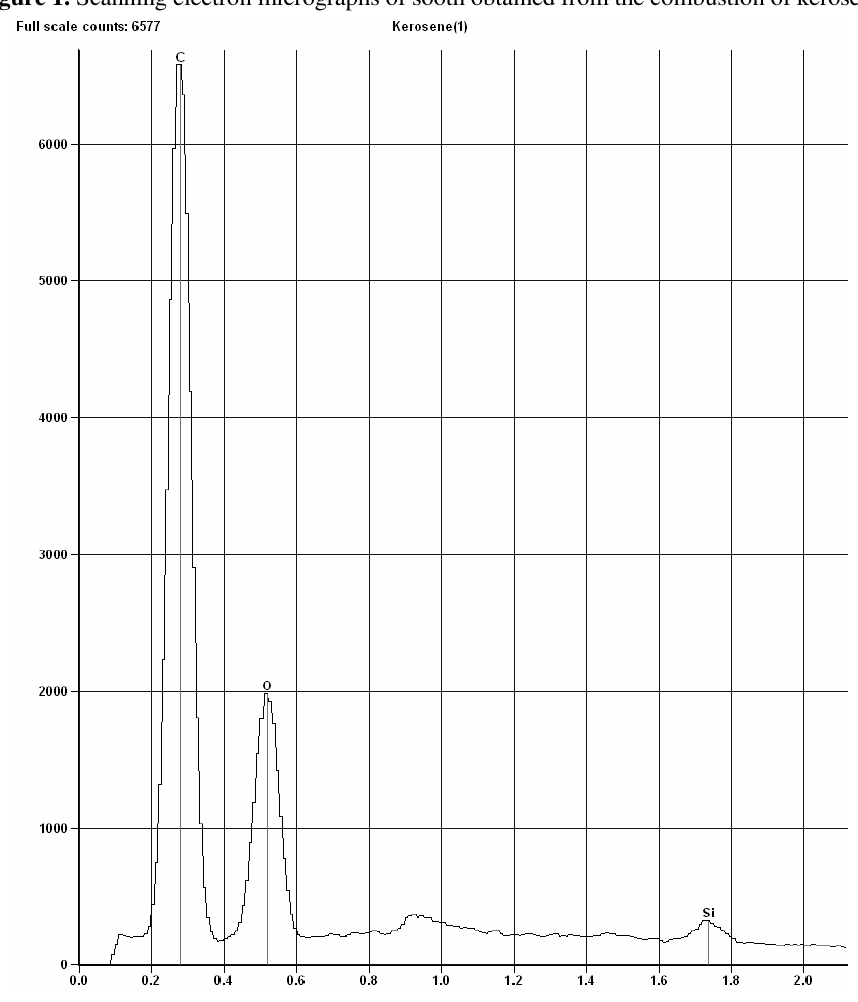
Figure 2, Energy dispersive x-ray spectra of sooth obtained from the combustion